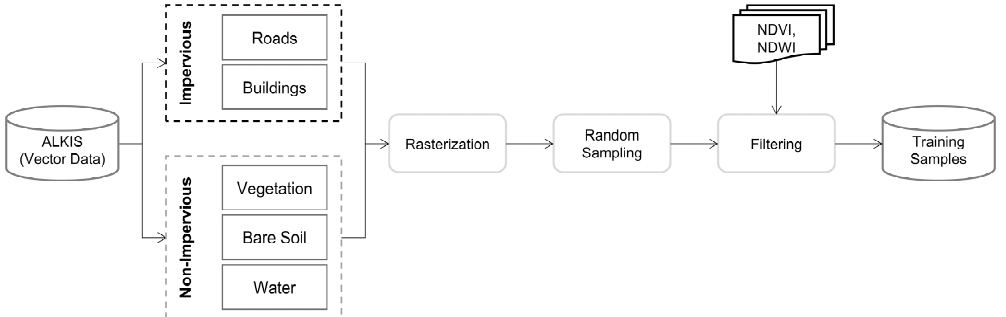
Figure 3. Schematic workflow for the generation of training samples for the classes “impervious” and “non-impervious”. Within representative ALKIS land use vector data of roads, buildings, vegetation, bare soil, and water, random training samples were generated and filtered by NDVI and NDWI thresholds. This figure was modified based on the Figure 2 of Zhang et al. [39].